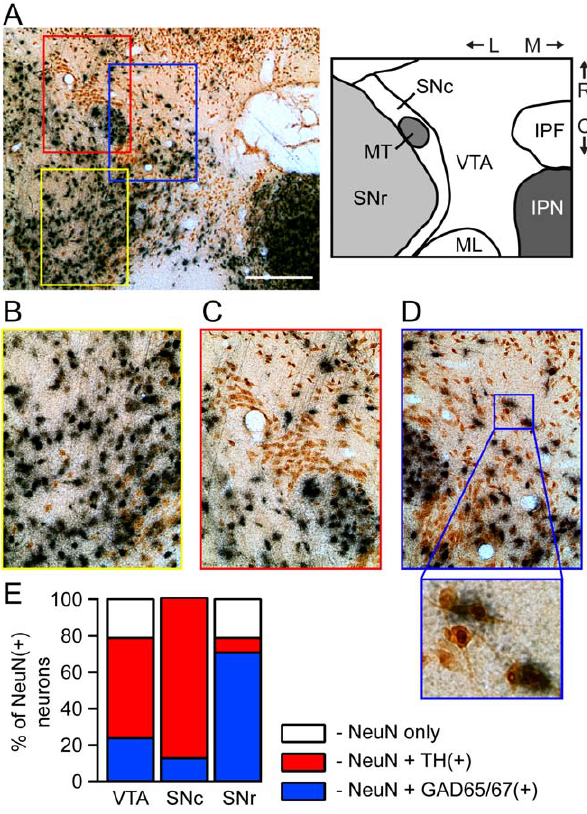
Figure 1. Mean density of GABA neurons in VTA: approxi- mately 20% are GABAergic. In horizontal brain slices containing the VTA and the SN the general neural marker NeuN was cytochemically visualized with the secondary label DAB (brown); GABAergic neurons were labeled using in situ hybridization against GAD65/67 mRNA (black grains). (A, left) Low magnification example image of one of the slices used to estimate the percentage of neurons that are GABAergic. Scale bar: 400 m m. Schematic (right) illustrates slice orientation and anatomical landmarks. (IPF: interpeduncular fossa; IPN: interpeduncular nucleus; ML: medial lemniscus; MT: medial terminal nucleus of the accessory optic track; SNc: substantia nigra pars compacta; SNr: substantia nigra pars reticulata; R: rostral; C: caudal; M: medial; L: lateral). Higher magnification images (color coded rectangles show location in (A)) show GAD65/67( + ) and GAD65/67( 2 ) in the SNr (B - yellow border), the SNc (C – red border), and the VTA (D – blue border with higher magnification section below). (E), Mean percentage of GAD65/67( + ) neurons in VTA, SNc, and SNr neurons and, for comparison, our prior estimates of % TH( + ) neurons